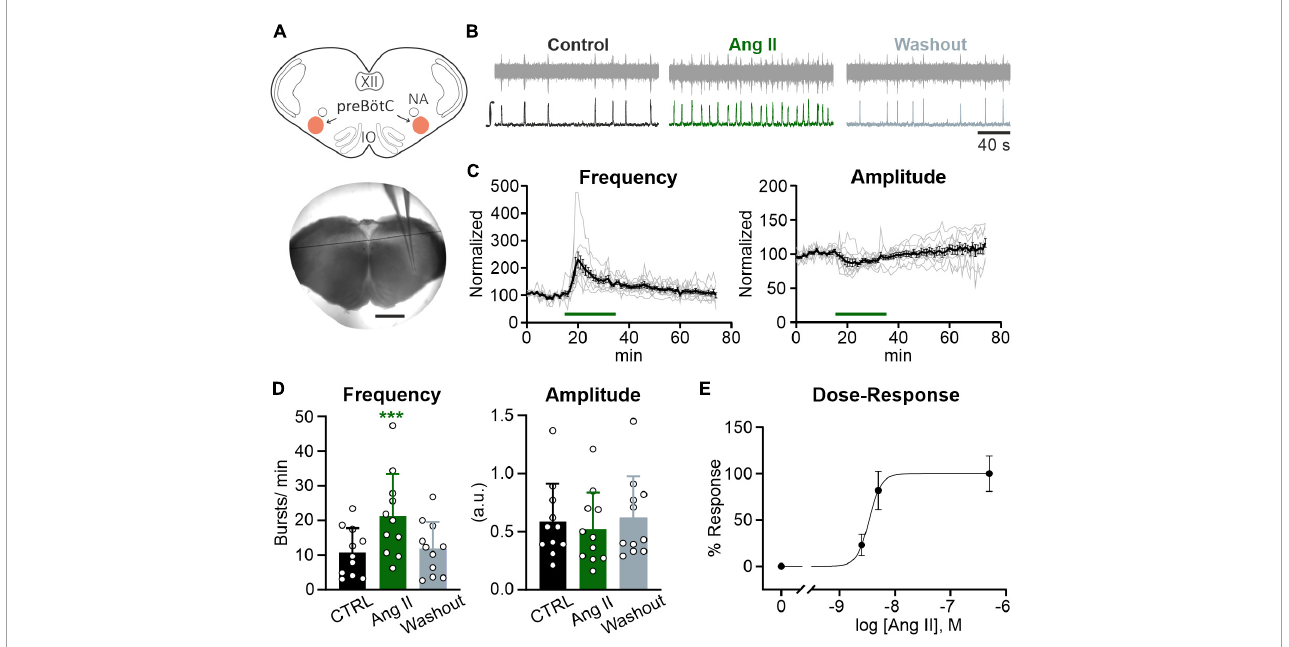
FIGURE2 Ang II modulates rhythmic activity in the preBötC. Local field potential (LFP) recordings were performed in the preBötC in rhythmic acute brainstem slices (600 µ m) from mice (P4–P12). (A) Schematic drawing of a brainstem slice with the preBötC marked in red (NA: nucleus ambiguus, IO: inferior olive) and an acute slice with the recording electrode placed in the preBötC. Scale bar 1 mm. (B) Example traces of the recorded (upper traces) and integrated (lower traces) LFP for each condition. Basic rhythmic activity was recorded for 15 min (control), followed by a 20 min Ang II treatment and a 40 min washout. (C) Recordings over time. Data after application of Ang II (500 nM) was normalized to the baseline (control condition). Gray traces show each individual recording ( N = 10 slices) and the black trace the mean value. (D) Charts show the averaged data of 5 min intervals for the different conditions (CTRL 10–15 min, Ang II 20–25 min, Washout 70–75 min). The data are presented as mean ± SD and were tested using a RM one-way ANOVA. *** p < 0.001. (E) Dose-Response graph of 2.5 nM ( N = 7 slices), 5 nM ( N = 6 slices), and 500 nM Ang II. The frequency was used for this